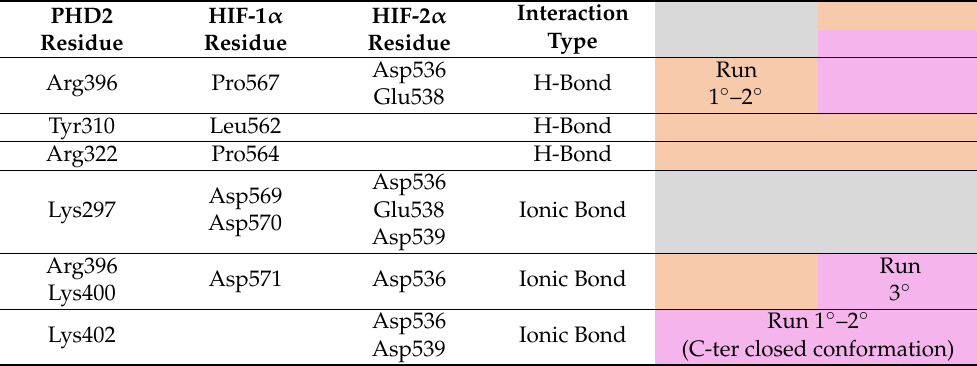
Figure 3. RMSD and RMSF plots calculated on PHD2/HIF-1α and PHD2/HIF-2 α complexes C-alpha over time. ( A ) RMSD (left) and RMSF (right) of the PHD2/HIF-1α complex. The four simulations that were run are shown in different colors: the first (orange), the second (blue), the third (turquoise), and the fourth (green). ( B ) RMSD (left) and RMSF (right) plots of the PHD2/HIF-2α complex. The first simulation is indicated in orange, the second in blue, and the third in turquoise. Table 1. Conserved and specific interactions of PHD2/HIF-1 α and PHD2/HIF-2 α complexes with a frequency cutoff < 20%. Gray is for conserved interactions, while HIF-1 α specific interactions are marked in orange. HIF-2 α specific interactions are highlighted in